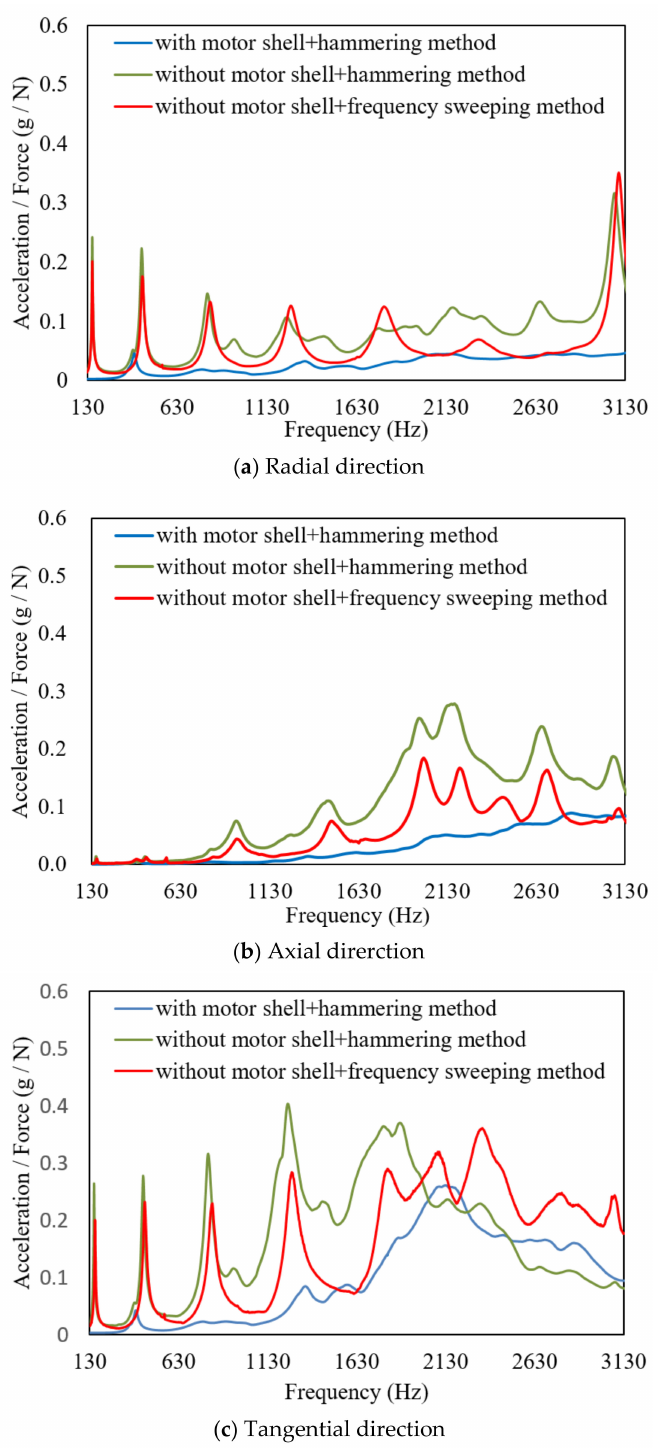
Figure 4. Acceleration frequency-response curves of motor